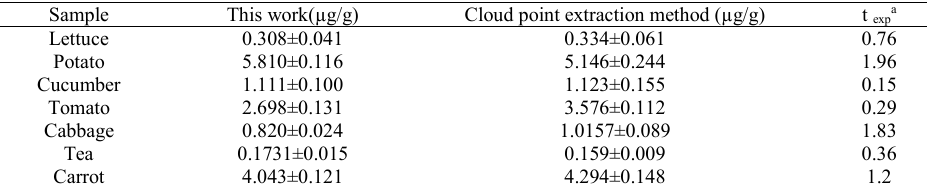
Table 2a: Results of determination of Mo (VI) in plant food stuff samples. Table 2a. Results of determination of Mo (VI) in plant food stuff samples